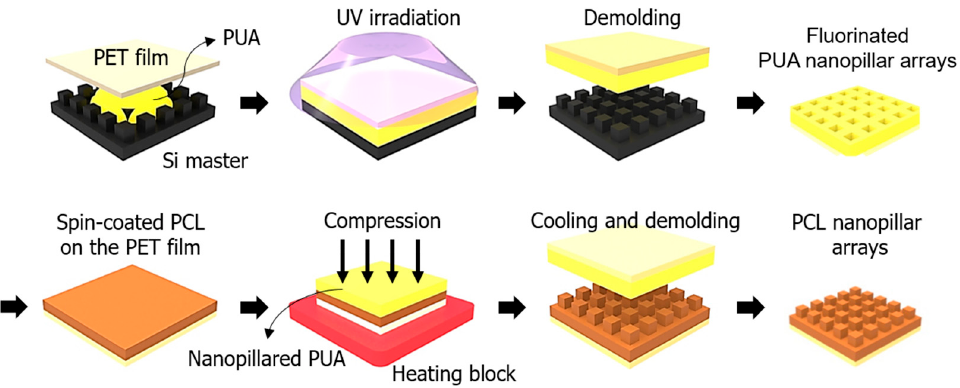
Figure 1. Schematic of the fabrication process for PCL nanopillar arrays using the thermal imprinting technique.